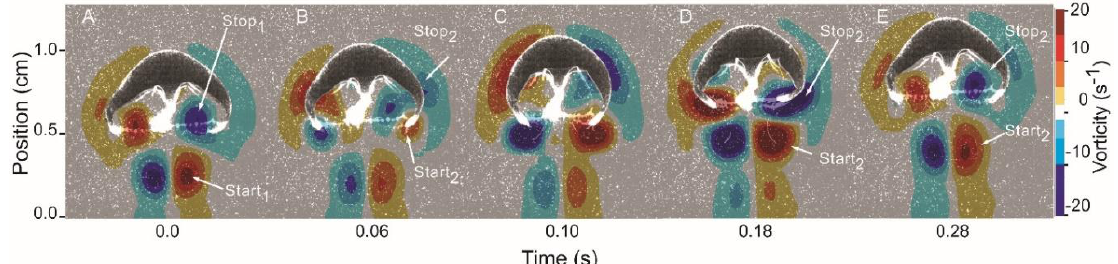
Figure 1. Vortex circulation development during bell pulsation by the hydromedusa Eutonina indicans . ( A ) Relaxed bell position between contraction cycles of a medusa (0.74 cm relaxed bell diameter) swimming in a linear, vertical direction. Residual circulation of the previous pulsation cycle is evident as starting vortex flow in the wake (Start 1 ) and opposite-sign flow in the subumbrellar cavity (Stop 1 ); ( B ) Initiation of bell contraction with starting vortex formation at the bell margin (Start 2 ) accompanied by an increase in stopping vortex circulation in the mid-bell region (Stop 2 ); ( C ) Continued bell contraction and increased circulation of both starting and stopping vortices; ( D ) Separation of starting vortex ring (symmetrical, opposite-sign on either side of the bell) from the bell margin with movement of the stopping vortex circulation along the exumbrellar surfaces past the bell margin and into the subumbrellar cavity during the refilling phase of bell relaxation; and ( E ) Return to the relaxed bell position between contraction cycles. The remnants of starting and stopping vortices remain in the wake and within the subumbrellar cavity, similarly to the end of the previous pulsation cycle (panel A).